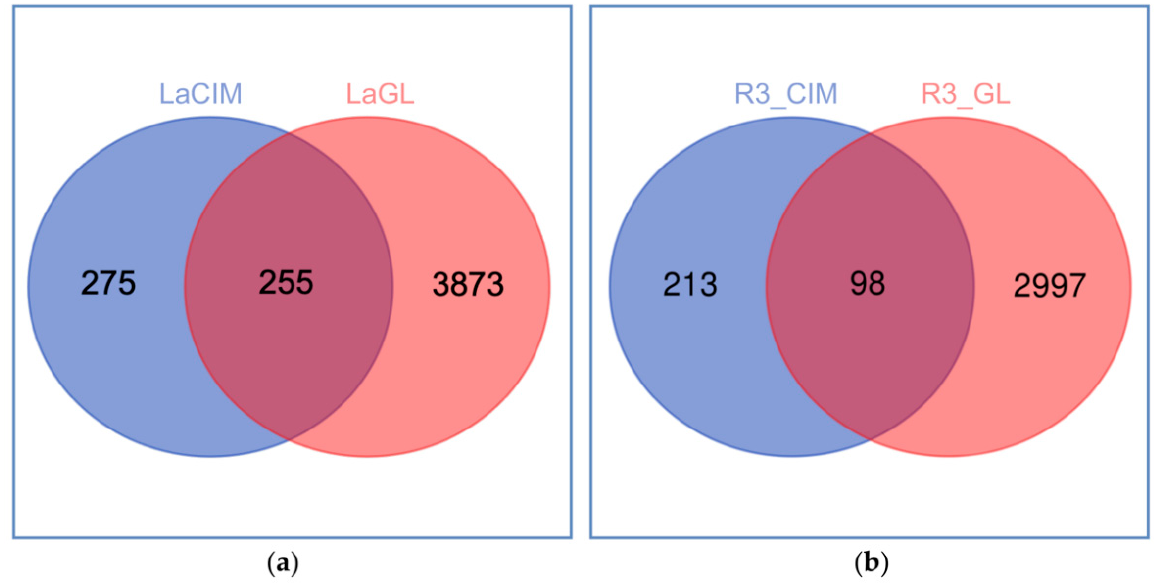
Figure 2. Venn diagram of the proteins identified with MaxQuant freeware in the cement and gland proteome of pelagic gooseneck barnacle L. anatifera . Unique and shared proteins between ( a ) all proteins identified in the cement (LaCIM) and gland proteome (LaGL); and ( b ) all proteins identified in the three biological replicates of the cement (R3_CIM) and gland proteome (R3_GL).